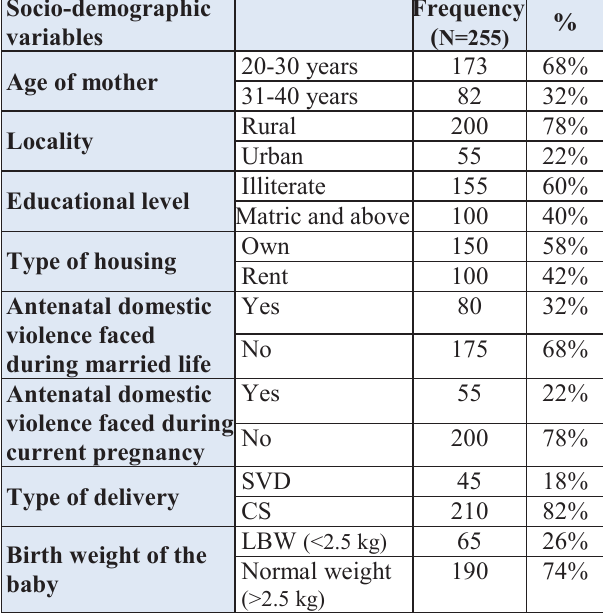
Table-1: Antenatal domestic violence according to socio- demographic variables